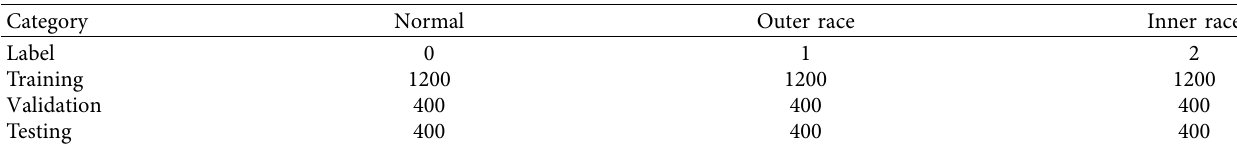
Table 4: Samples in the Paderborn dataset.